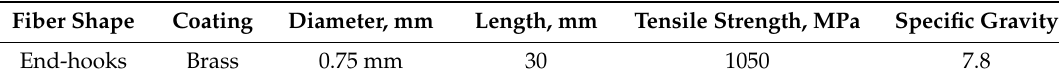
Table 2. Properties of steel fibers.